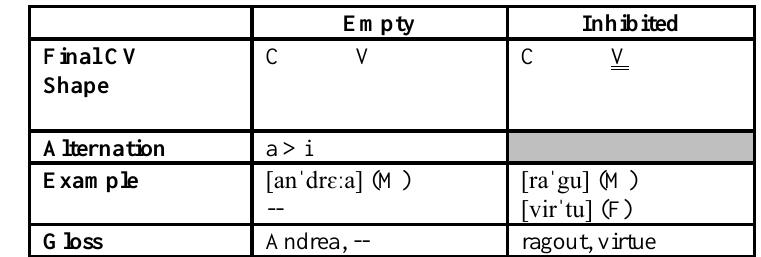
Table 4. C and V empty vs.